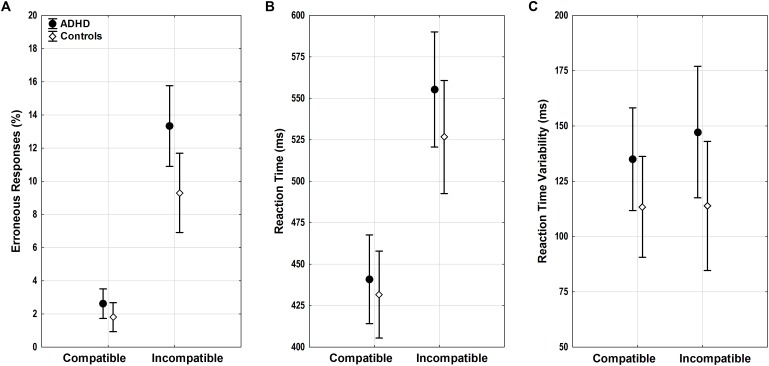
Flanker task performance. (A) Erroneous responses, (B) reaction time (RT), and (C) RT variability with means and 95% confidence intervals are displayed for compatible and incompatible trials in adults with ADHD (black) and control adults (white). ADHD, attention-deficit/hyperactivity disorder.